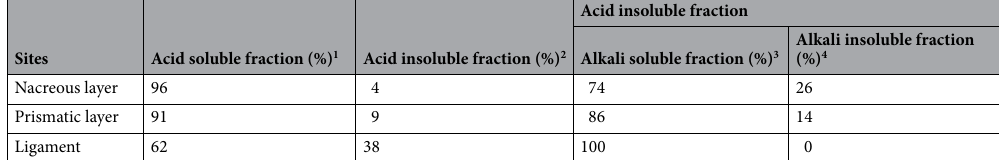
Table 1. Proportion of the components in the shell of P. fucata. 1 Calcium carbonate + proteins, 2 chitin + proteins, 3 proteins, 4